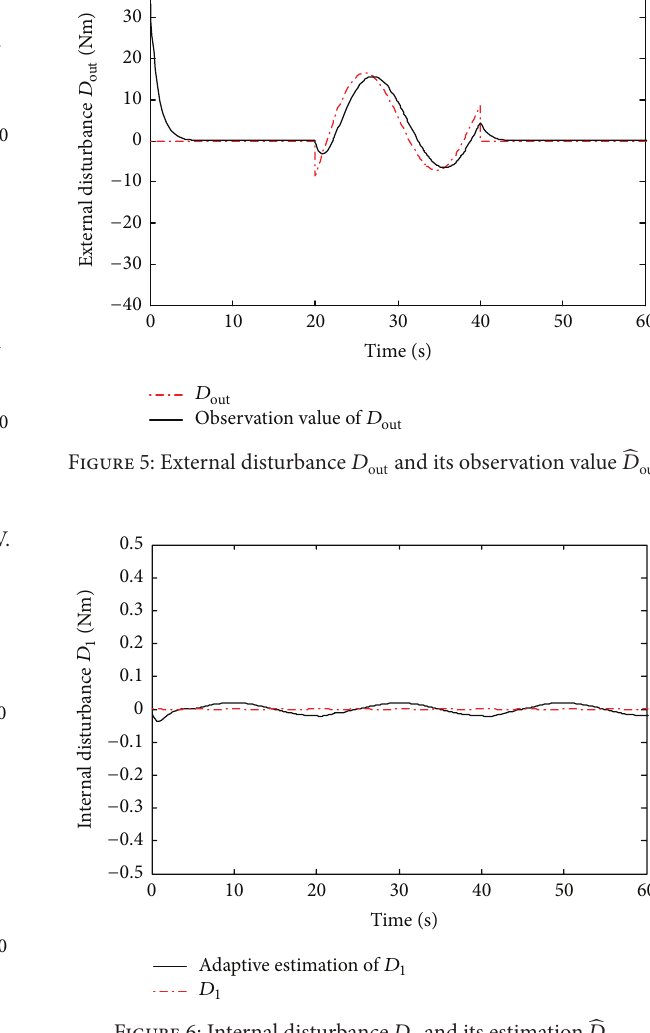
Figure 6: Internal disturbance 𝐷 1 and its estimation